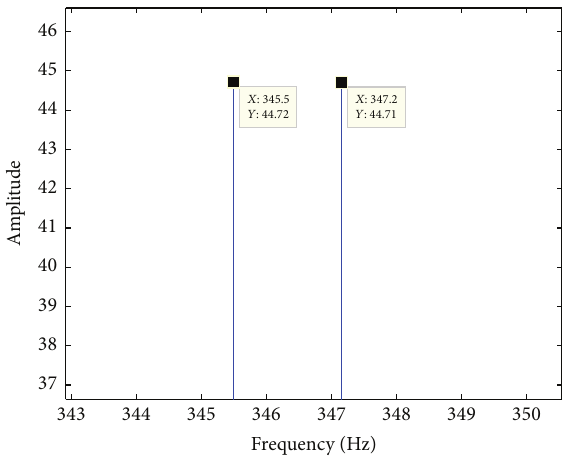
Figure 2: Spectrum of recovered slow-time echo signal.